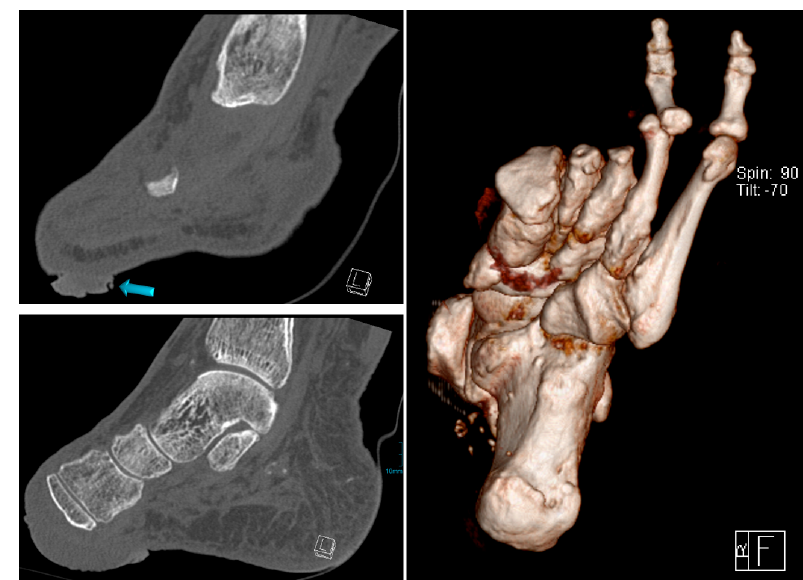
Figure 7. Radiological imaging of the foot in Case 1, arrow shows verrucous tumor mass.